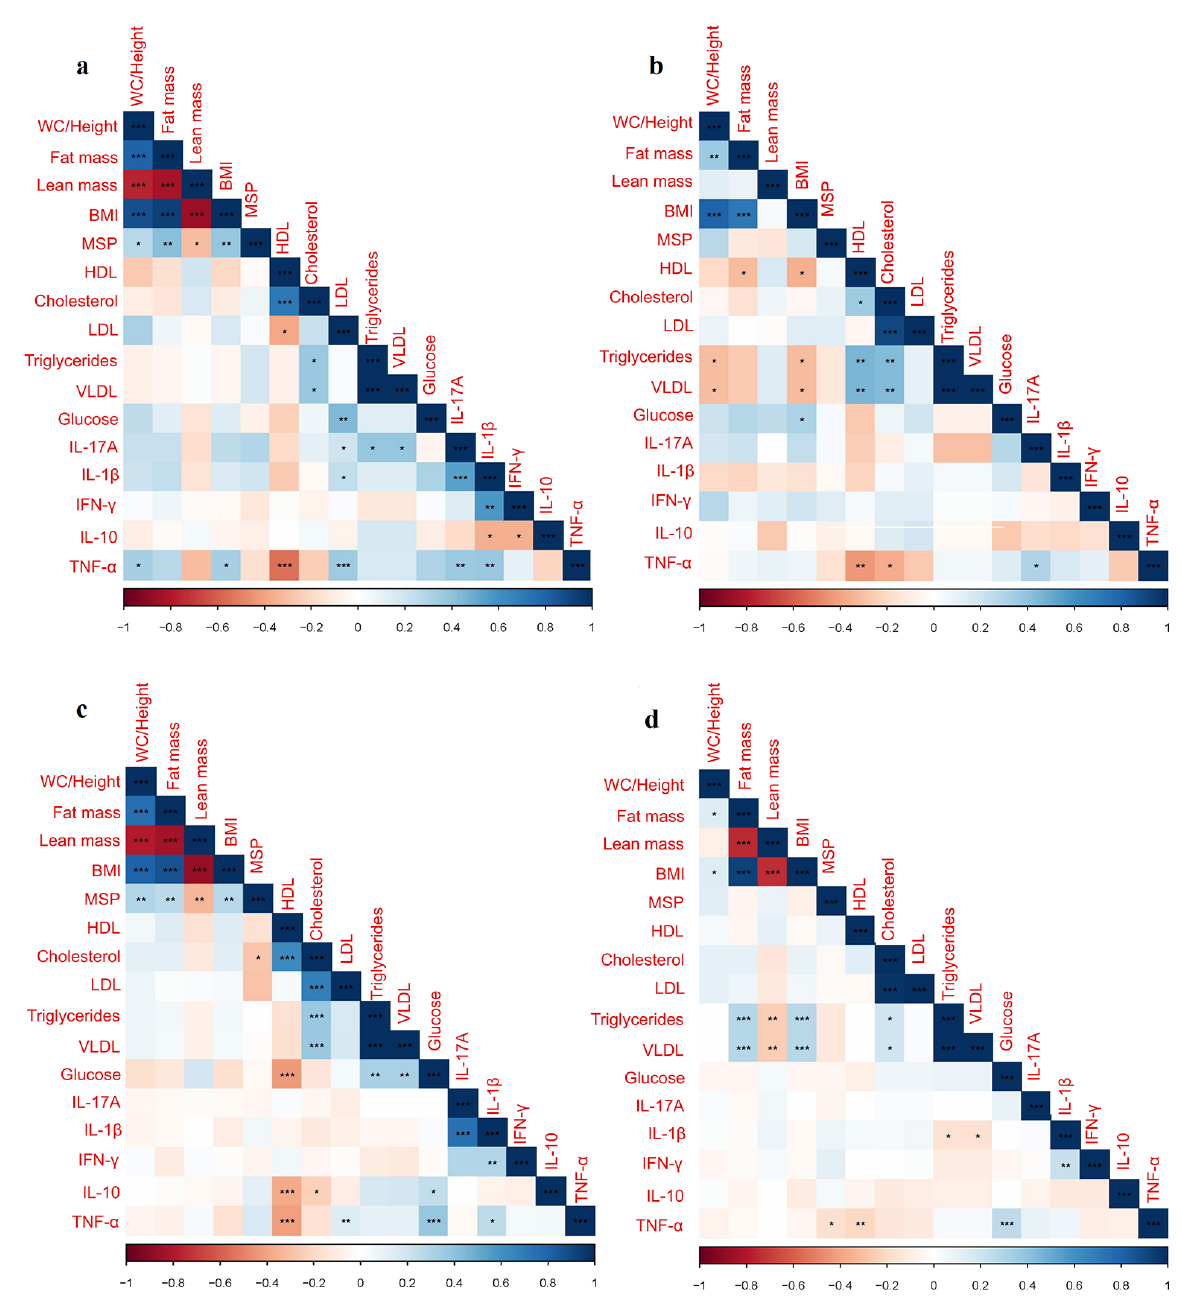
Figure 1. Correlations between anthropometric, blood pressure data, biochemical and immunological markers. a: Physically active men (n=40); b: Sedentary men (n=54); c: Physically active women (n=98); d: Sedentary women (n=184). Positive correlations are indicated in blue, and reverse correlations areindicated in red. Darker color tones indicate higher r values. pvalues are indicated based on Spearman's rank correlation tests (* p< .05; ** p< .01; *** p<.001;**** p< .0001). Variable grouping is based on principal component analysis using the R packet corrplot.WC: Waist circumference; BMI: Body mass index; MSP: Mean systolic